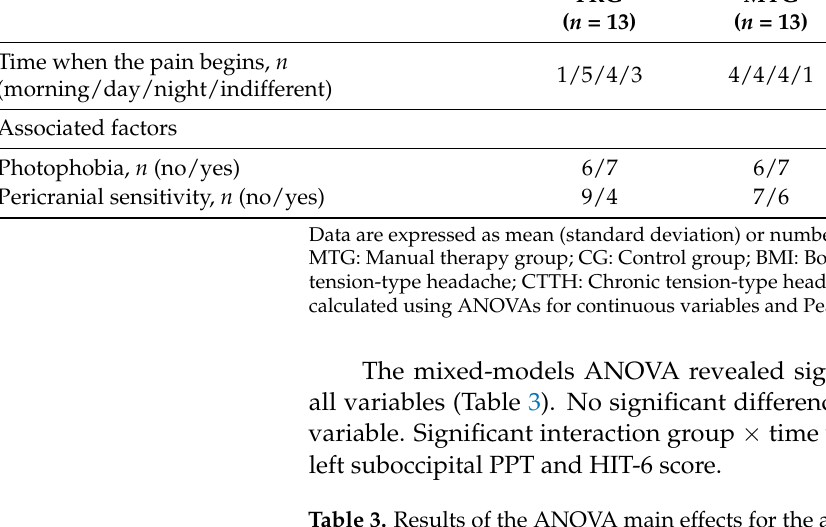
Table 3. Results of the ANOVA main effects for the analyzed variables.